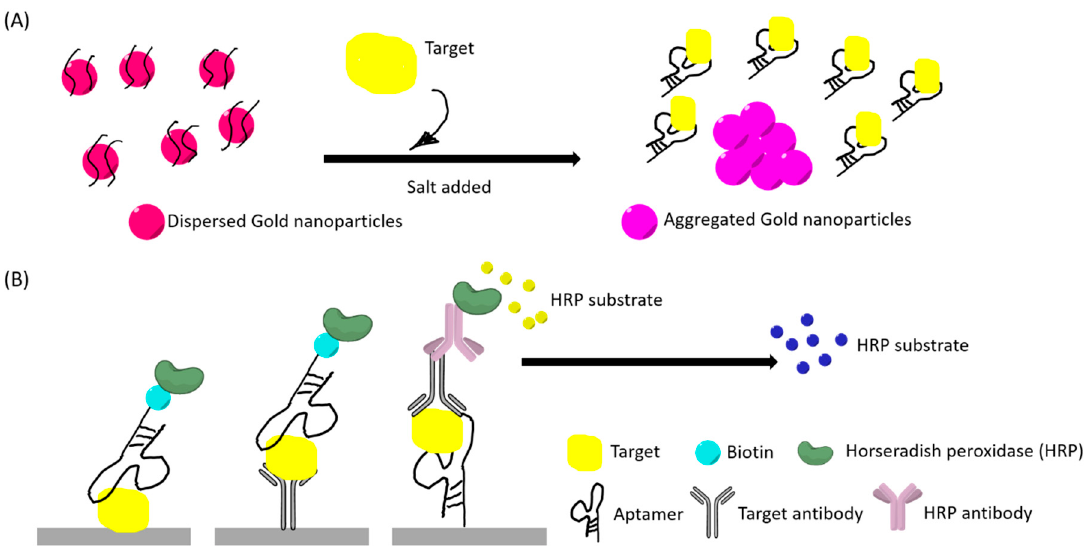
Figure 3. ( A ) An example illustration of a “red to purple” colorimetric sensor using gold nanoparticles (AuNPs). The left had side illustrates the initial stage where AuNPs are dispersed by aptamer-coating, thus having a red appearance. AuNPs aggregated after target bind to the aptamer and salt addition. ( B ) An example illustration of aptamer enzyme-linked sorbent assays. Primary antibody for the target and secondary antibody can be used in different sandwich assays. The color changes in both ( A ) and ( B ) can be observed with naked eyes and quantified by optical instruments.